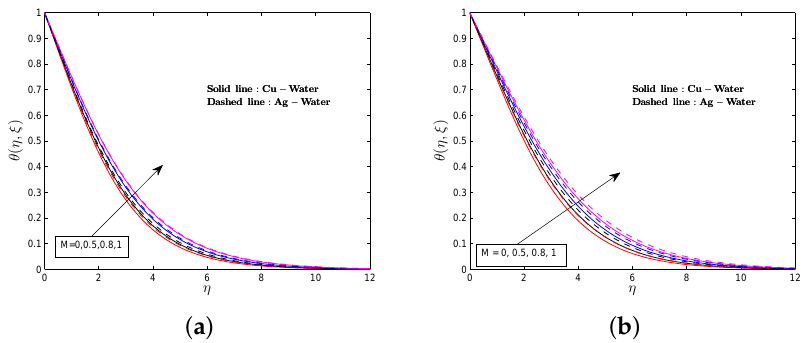
Figure 8. Temperature profiles for various values of M . ( a ) vertical plate; ( b ) horizontal plate.